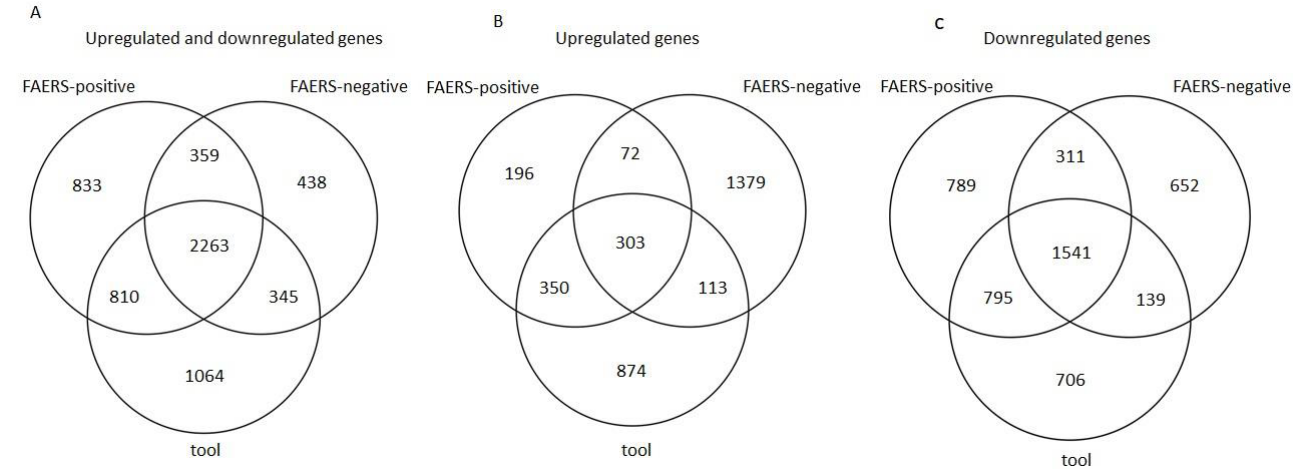
Figure 2. Venn diagrams showing the number of differentially expressed genes (FDR < 0.05 and log2(|FC|) > 1.5) induced by tool, FAERS-positive, and FAERS-negative compounds in rat cortical neuronal cell cultures. ( A ) Both upregulated and downregulated genes. ( B ) Upregulated genes only. ( C ) Downregulated genes only.